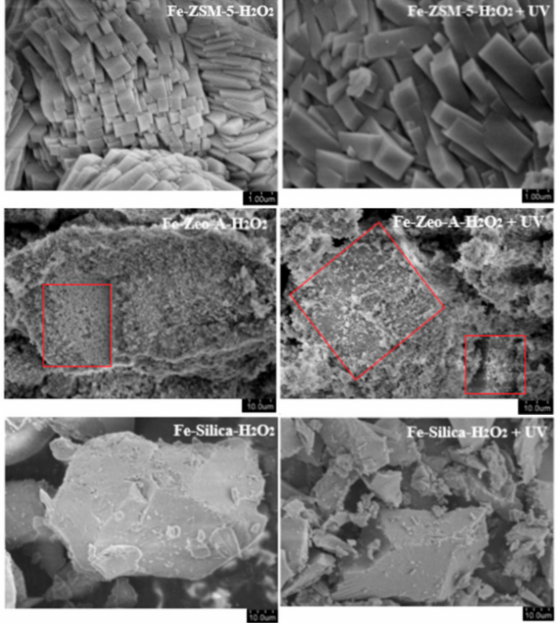
Figure 8. SEM images of Fe-ZSM-5, Fe-Zeo-A, and Fe-Silica after phenol degradation with H 2 O 2 and with H 2 O 2 +